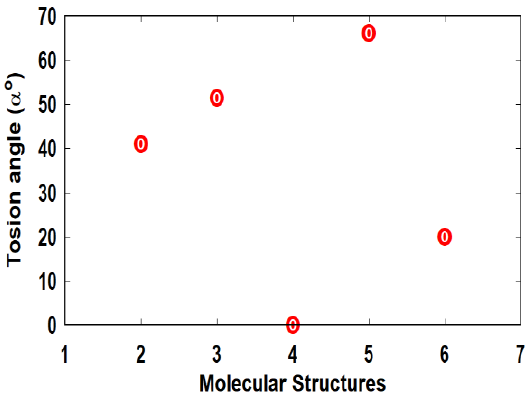
Figure 4: Dihedral angle as a function of molecular structures for six